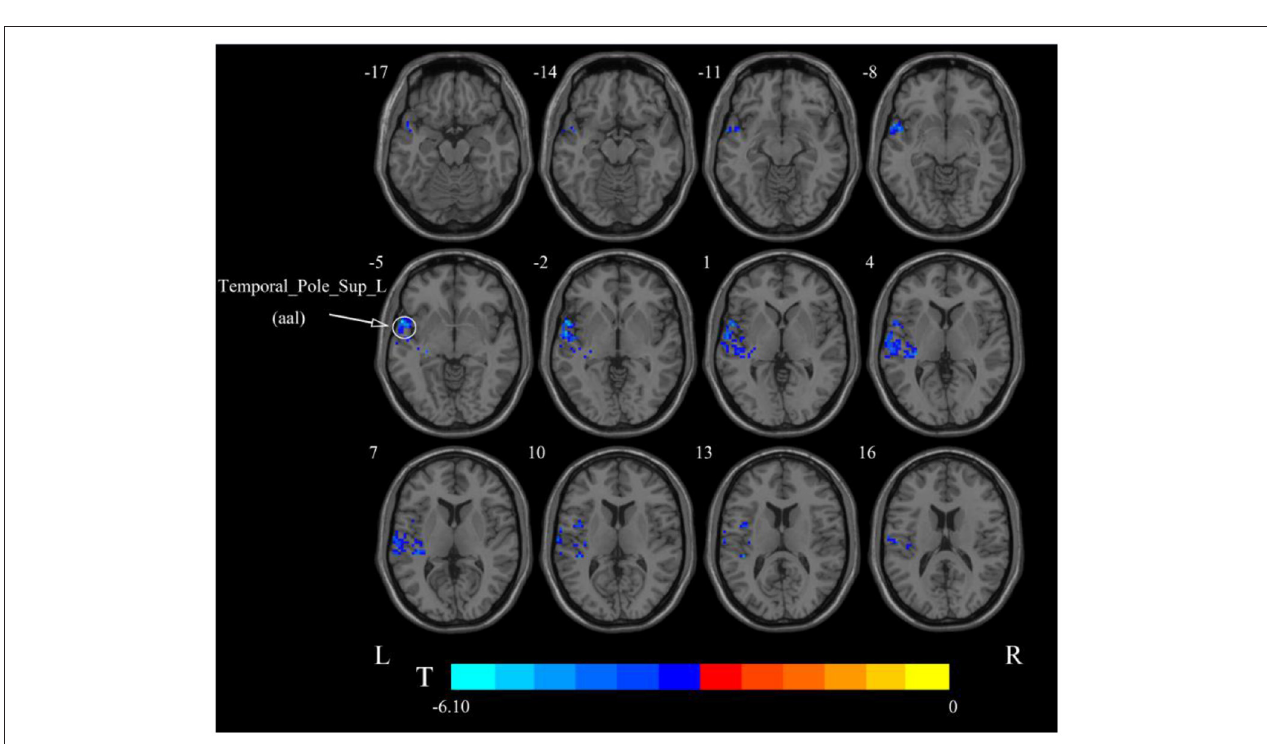
FIGURE 5 | Statistical maps showing ALFF change pre- and post-rTMS in the slow-5 band. Cool colors showing ALFF decreased after rTMS p < 0.05.